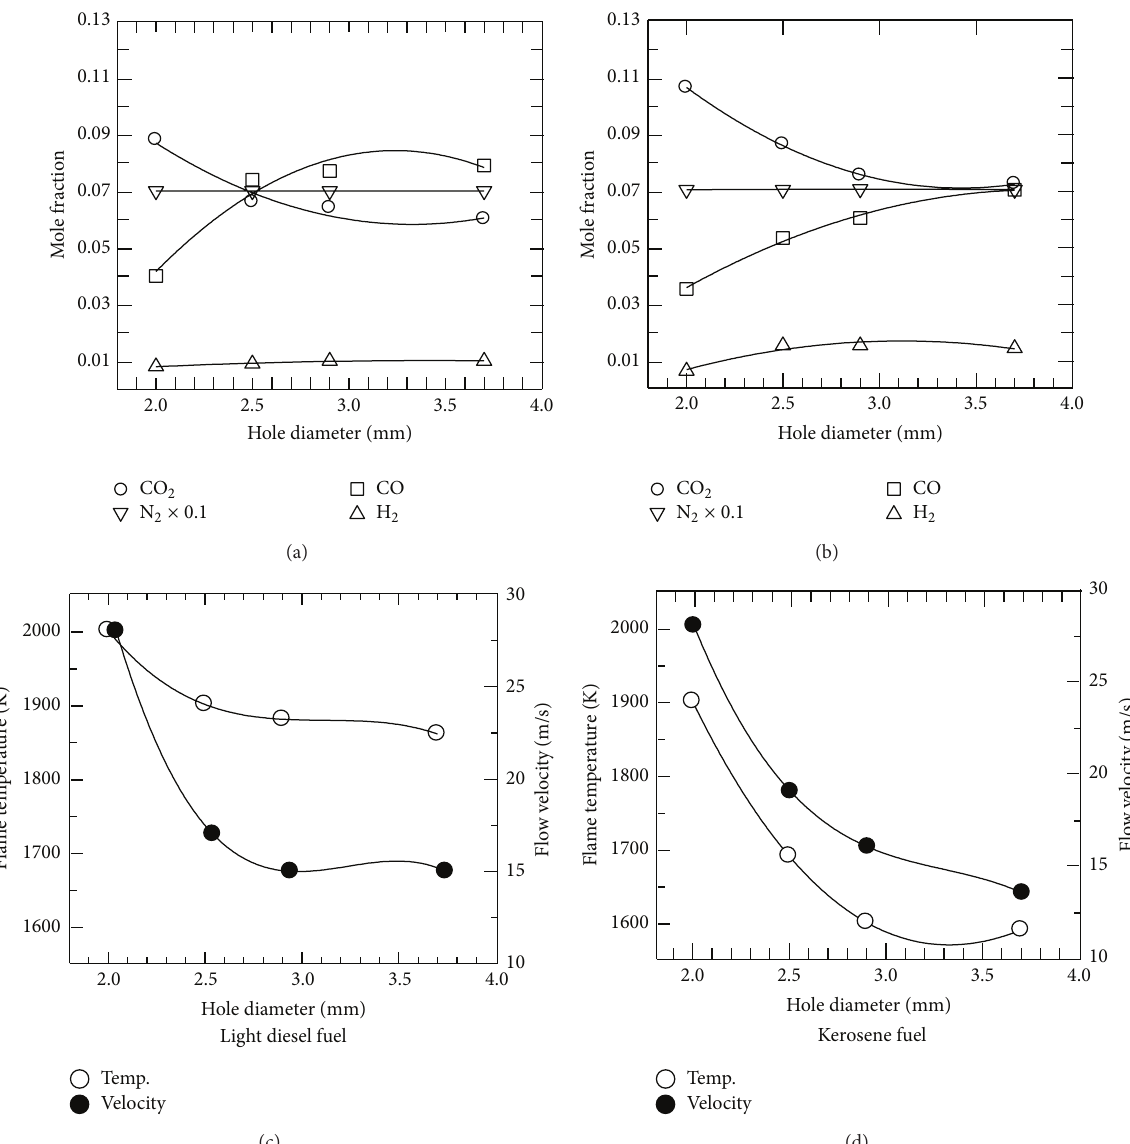
Figure 9: Effect of perforated plate holes diameter on flame structure for turbulent premixed air flame at residence time 5 ms, mean Reynolds number 11.08 × 10 3 , equivalence ratio 1.27, and pressure